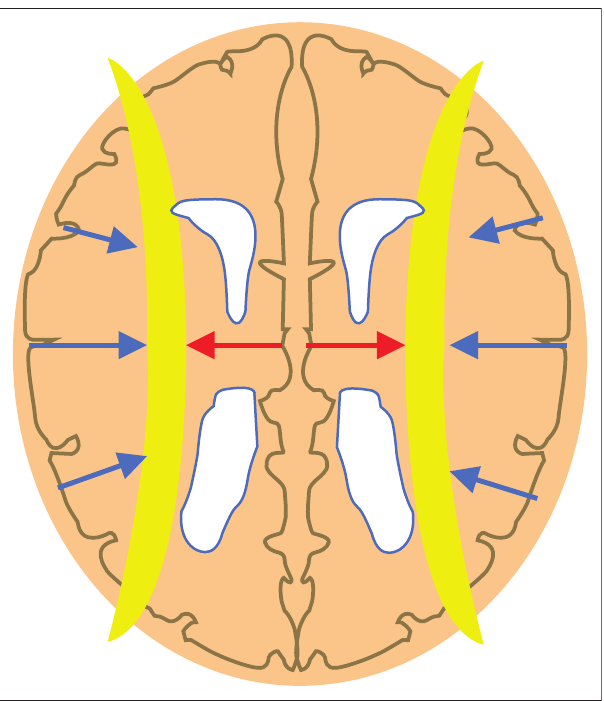
FIGURE 15: Schematic representation of the internal watershed regions (depicted in yellow overlay). The red arrows indicate the susceptible junction zones of the ventriculofugal vessels coursing away from the ventricles and ventriculopetal vessels coursing inward from the cortex (blue